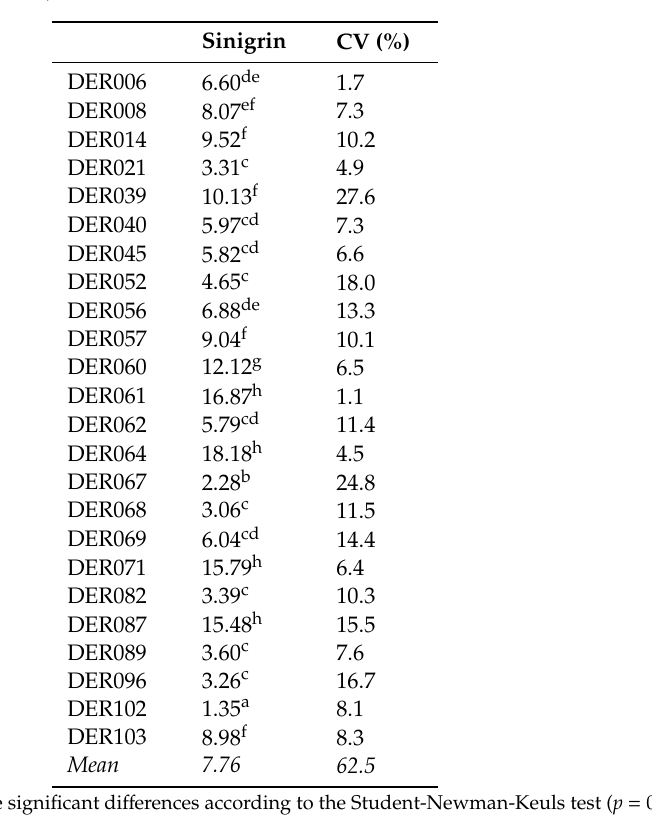
Table 5. Content in sinigrin (mg 100 g − 1 FW) and coe ffi cient of variation (CV, %) in the 24 populations of wall rocket evaluated ( n =